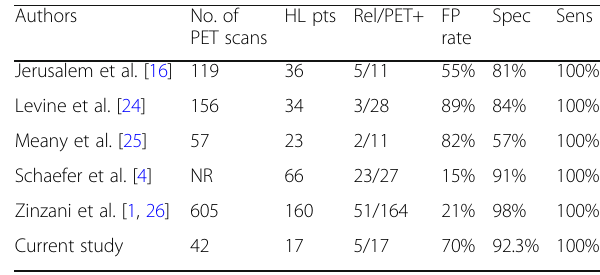
Table 5 Prognostic values of PET scan of HL patients